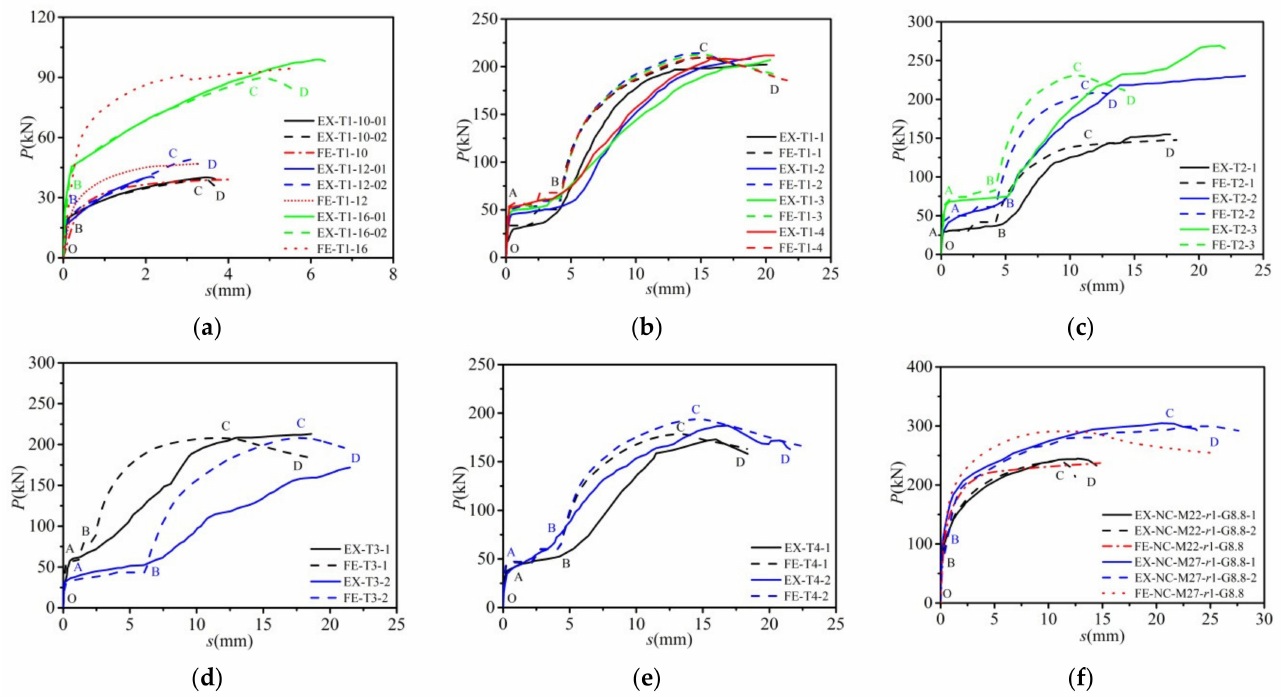
Figure 10. Comparison of force-slip curves between numerical models and experiments re- sults [18,19,26] (Reprinted with permission from Ref. [18]. Copyright year 2019, copyright owner’s